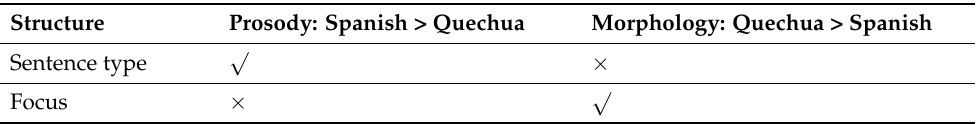
Table 5. Summary of the between-language influence in prosody and morphology for sentence type and focus (Quechua and Spanish